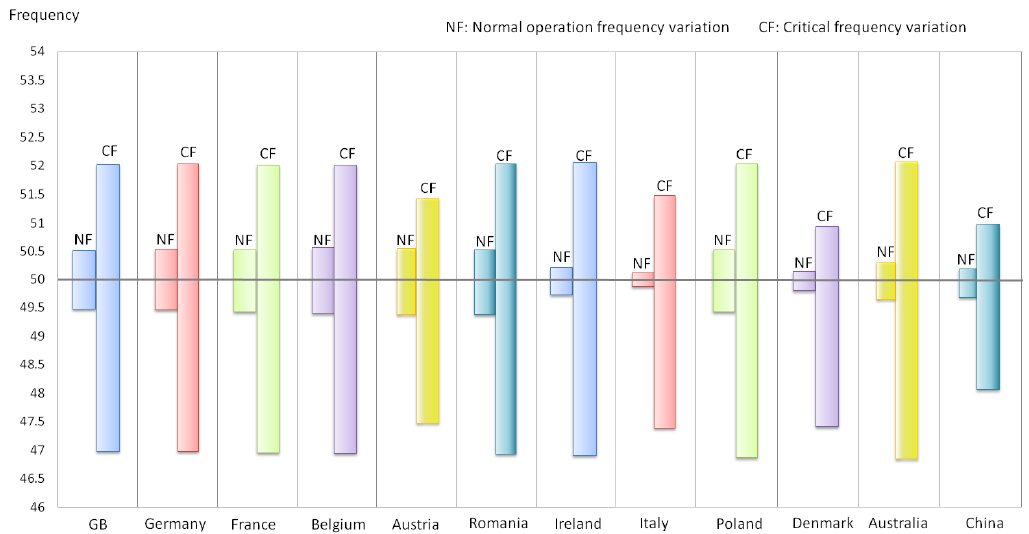
Figure 1. Comparison of the range of normal operation frequency variation and the range of critical frequency variations in different countries [1,10,11,13,15,17–26].